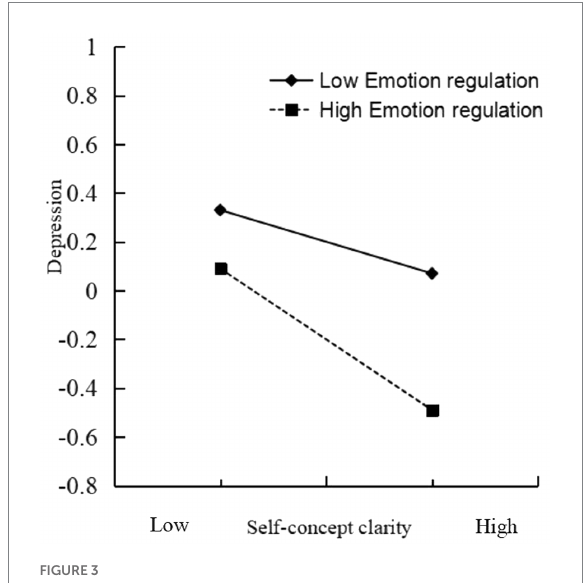
FIGURE 3 Interaction between self-concept clarity and emotion regulation